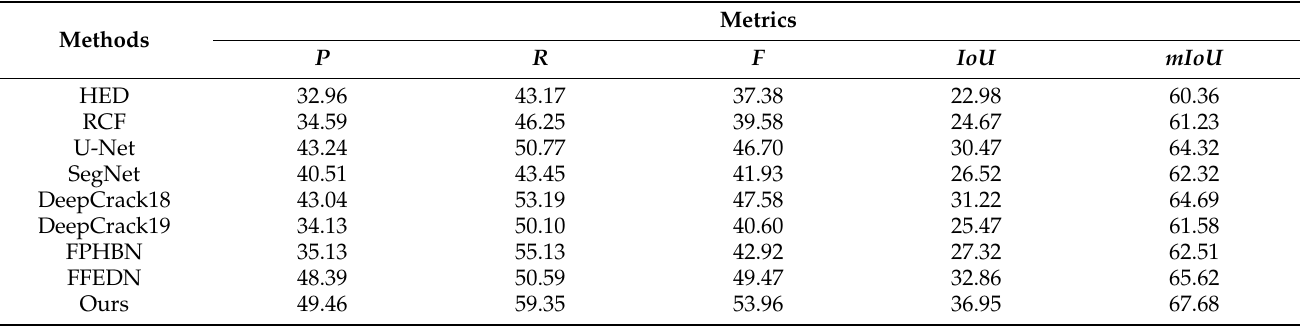
Table 4. Comparison results on generalization